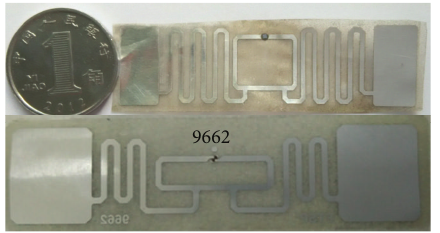
Figure 6: Photograph of the proposed RFID tag and